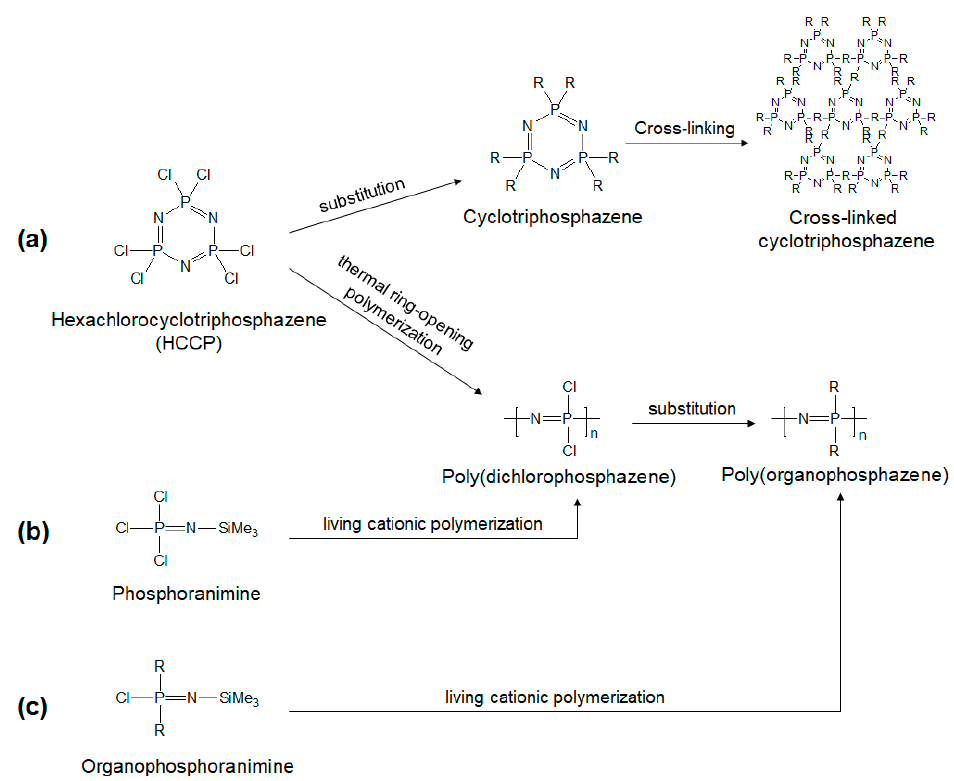
Figure 1. The synthetic routes of PPZs: ring-opening polymerization, living cationic polymerization and substitution reaction are the major techniques adopted. Synthetic route of PPZs from ( a ) HCCP, ( b ) phosphoranimine and ( c ) organophosphoranimine